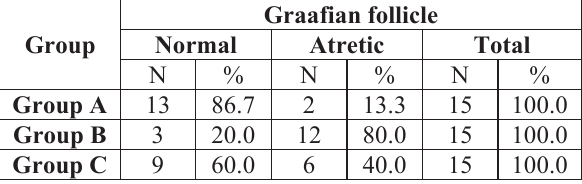
Table-1: Status of Graafian follicles observed in control group A, experimental groups B and C.